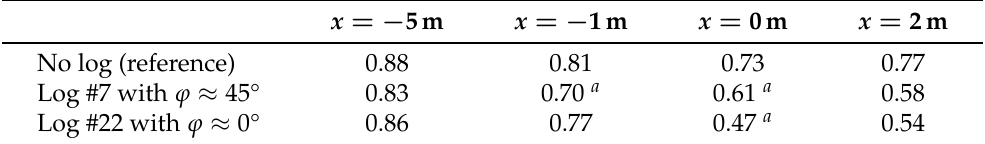
Figure 12. Streamwise surface velocity u in the vicinity of the pier for ( a ) log #7 with ϕ ≈ 45°, ( c ) log #22 with ϕ ≈ − 15° accumulated at the pier, and snapshots of ( b ) log #7 and ( d ) log #22 during PIV measurement. Table 3. Cross-sectional averaged streamwise surface velocity ¯ u [m/s] for AC 1 and AC 2 logs shown in Figure 12. The reference without a log accumulated at the pier is shown in Figure